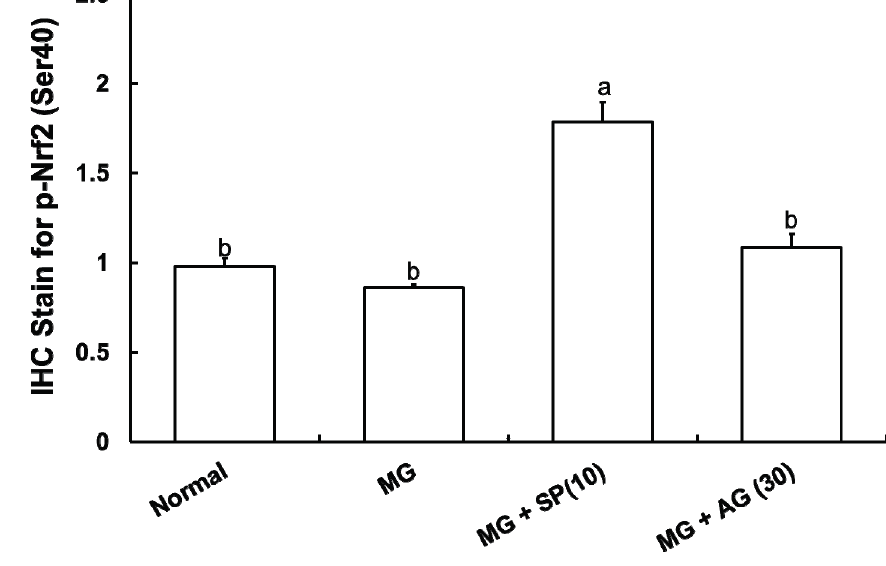
Figure 6. The IHC stain for hepatic p-Nrf2 levels. Normal: deionized water; MG: methylglyoxal (300 mg/kg body weight); MG + SP (10): methylglyoxal (300 mg/kg body weight) + scopoletin (10 mg/kg body weight); MG + AG (30): methylglyoxal (300 mg/kg body weight) + aminoguanidine (30 mg/kg body weight). (a,b) indicate statistically significant differences p < 0.05. Data are presented as mean ± SD ( n = 8/group). Bar: 100 micrometer.